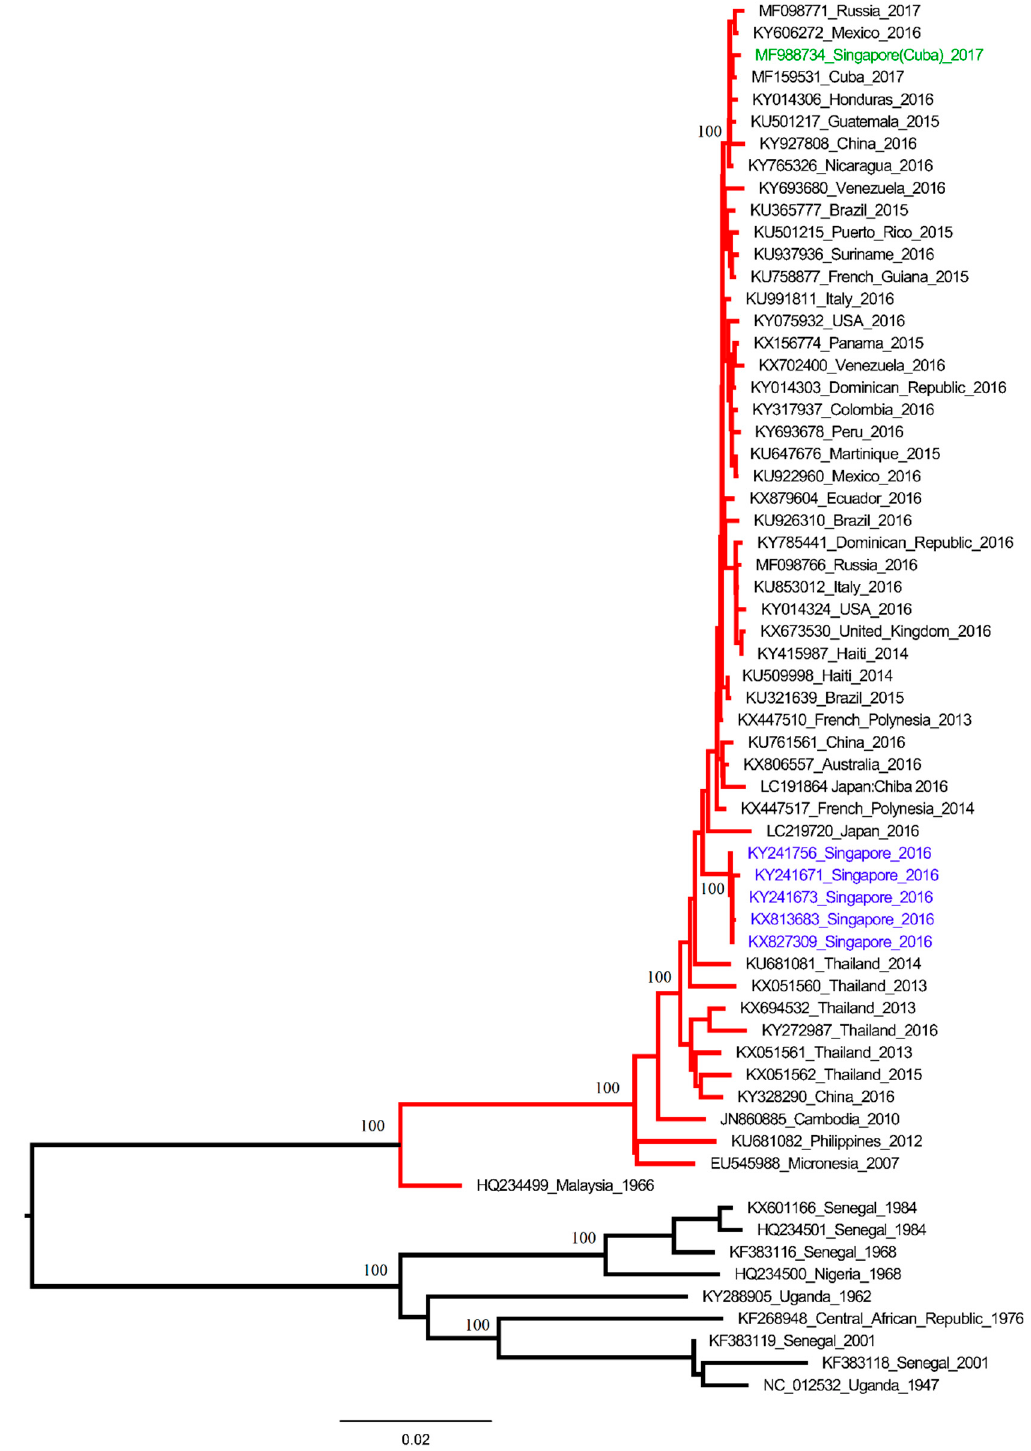
Figure 3. Phylogeny of ZIKV complete polyprotein. The case sequence is highlighted in green, whereas the outbreak strains in Singapore are highlighted in blue. Phylogenetic analysis was performed in MEGA7 (http://megasoftware.net/) program using the maximum-likelihood method based on the general time reversible model with gamma distribution and invariant sites. The robustness of the original tree was tested with 1000 bootstrap replications. Asian and African genotypes are represented by red and black branches respectively. Numbers on branches are bootstrap support values.